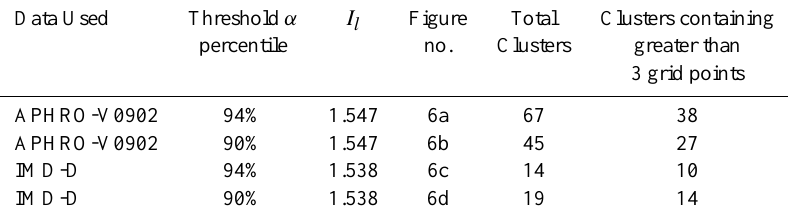
Fig. 5. (a) Representation of the grid for estimating Q jk and q jk , (b)–(c) diagrammatic representation for calculating time delay patterns.